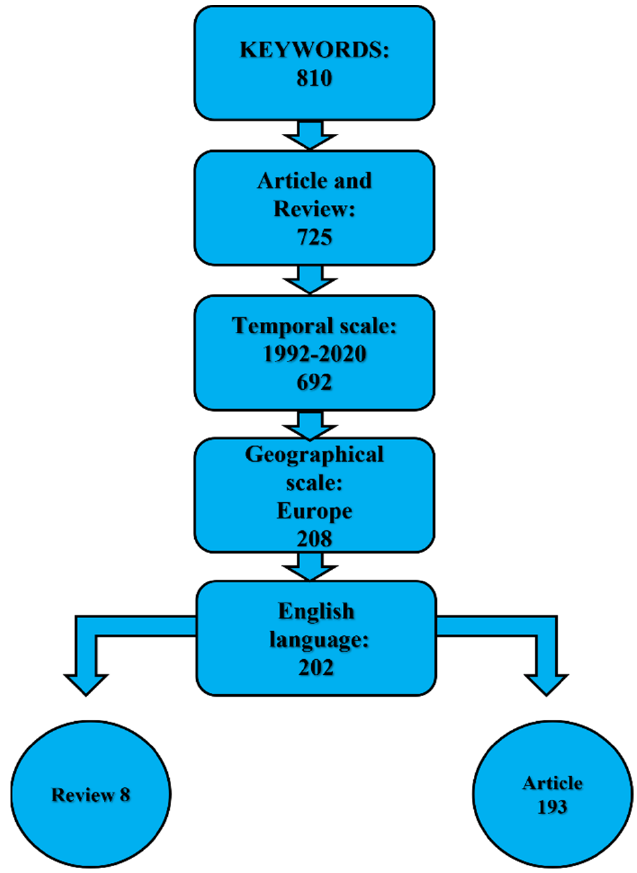
Figure 1. Flow diagram from literature research.